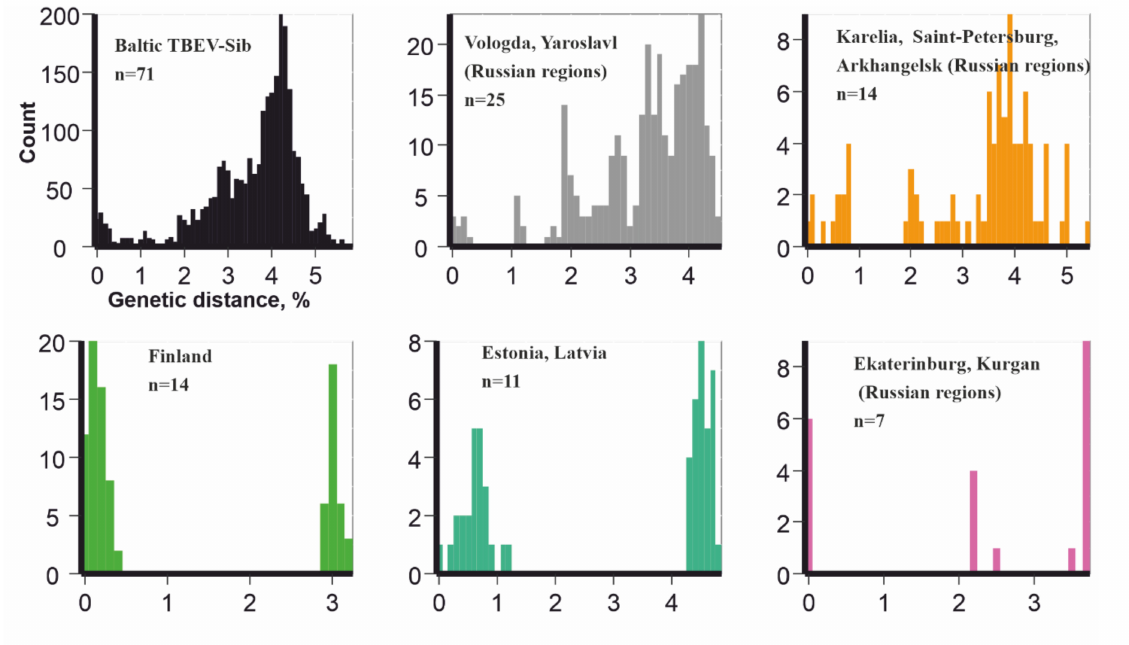
Figure 3. Pairwise genetic distances for all Baltic TBEV-Sib subgroup representatives ( n = 71); Baltic TBEV-Sib from the Vologda and Yaroslavl regions ( n = 25); Baltic TBEV-Sib from Karelia, Saint-Petersburg and Arkhangelsk regions ( n = 14); Baltic TBEV-Sib from Finland ( n = 14); Baltic TBEV-Sib from Estonia and Latvia ( n = 11); and Baltic TBEV-Sib from the Ekaterinburg and Kurgan regions ( n = 7).